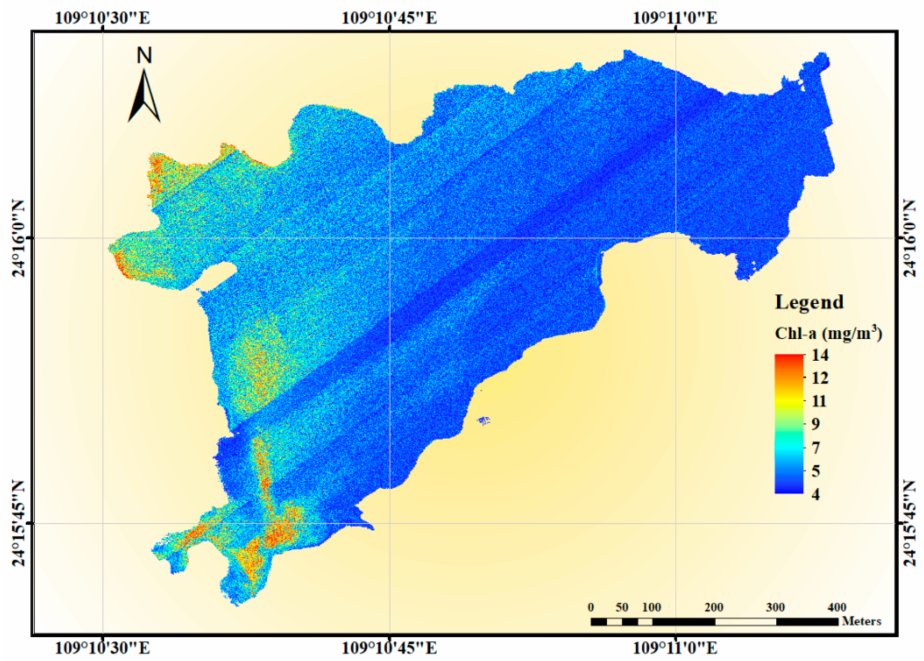
Figure 5. Distribution map of Chl-a (mg/m 3 ) obtained using the CBR model with Beigong UAV-borne hyperspectral imagery.